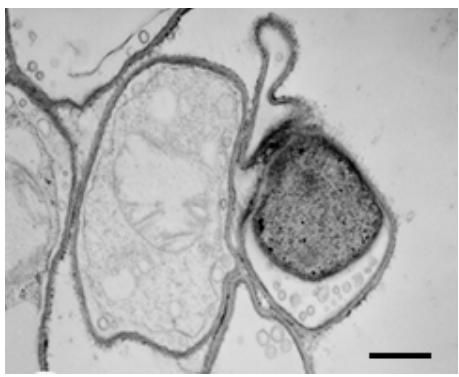
Figure 7. Cell death after treatment with 200 μ g/mL phenylethylresorcinol; several cells are transparent and empty. TEM. Scale bar: 1 μ m.